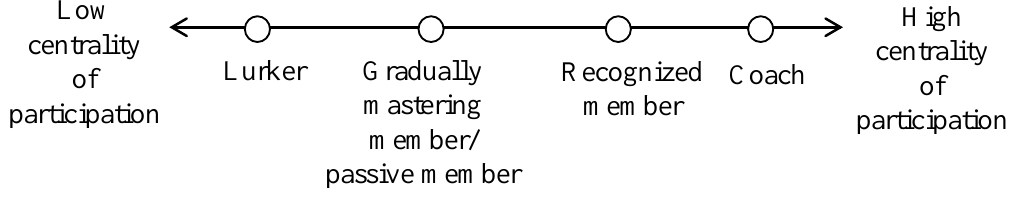
Figure 5 . Proposed continuum for roles of social participation in mobile social media